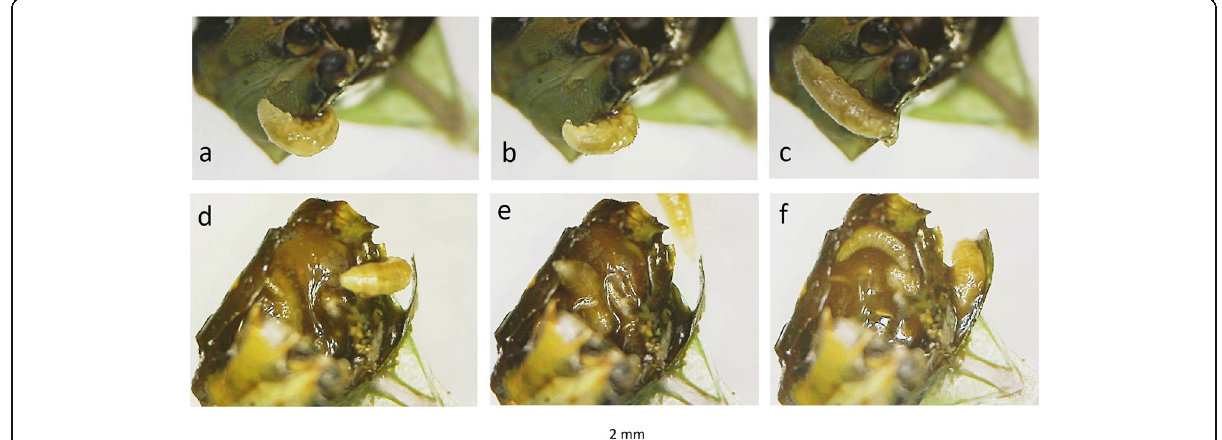
Fig. 3 a – f emergence of third larval instar of Megaselia scalaris from thorax of Nezara viridula (L.) for